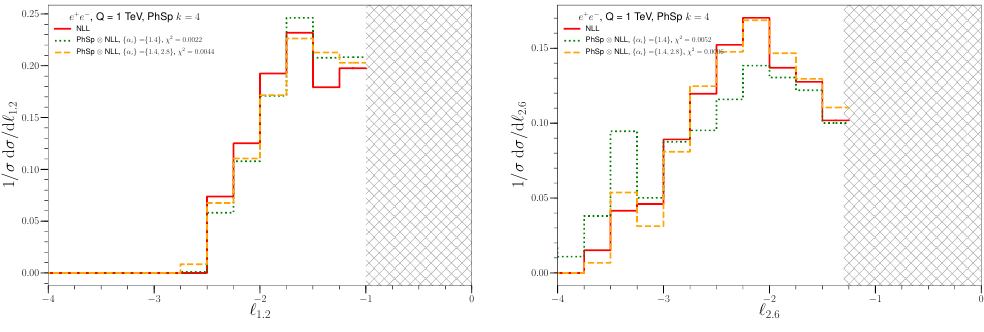
Figure 6 . Same as (cid:12)gure 5, but using our NLL analytic predictions instead of Herwig . (cid:11) j =2 : 6, there is a dramatic improvement going from the best possible reweighing with n